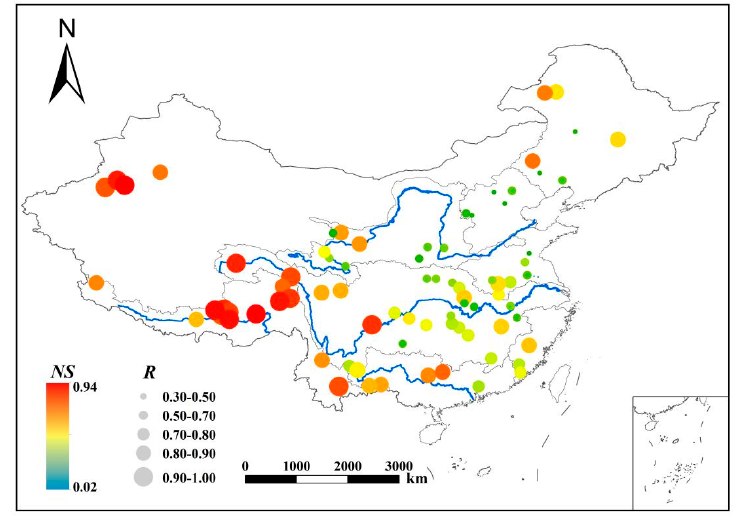
Figure 5. Spatial distribution of R and NS for the 79 stations.